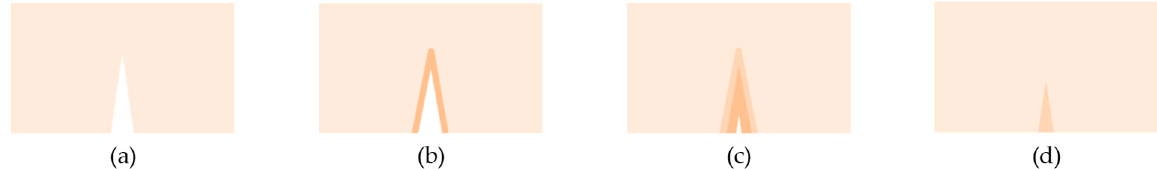
Figure 1. The basic principle of crack healing in asphalt pavement: ( a ) a crack generated in asphalt mastic; ( b ) the ‘mobile phase’ induced at the crack face; ( c ) closure of the crack by the ‘mobile phase’ and ( d ) immobilisation after healing (Hager et al., 2010).